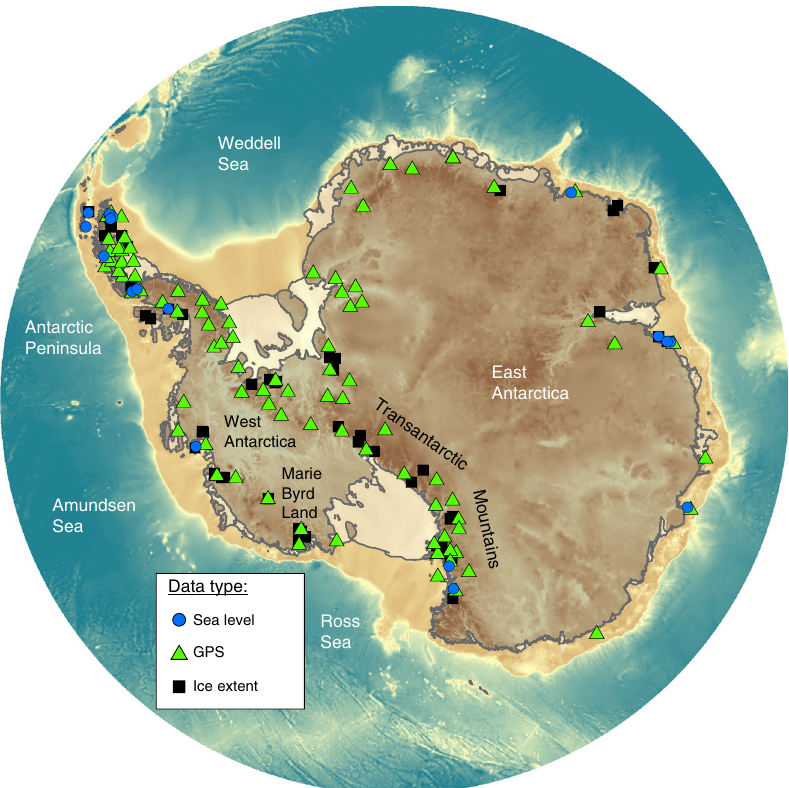
Fig. 7 Location of GPS sites and data relating to past ice extent and sea level around Antarctica. Information on past ice extent can be derived from surface exposure dating of erratics and bedrock outcrops; locations extracted from the ICE-D Antarctic Database (http://antarctica.ice-d.org/). Sea-level data are documented in Whitehouse et al. 17 , GPS data are archived by UNAVCO (http://www.unavco.org/data/gps-gnss/gps-gnss.html). Bathymetry from BEDMAP2 solid Earth response to ice loss, and the accompanying fall in sea level, will have a stabilising effect on grounding line dynamics 71 .